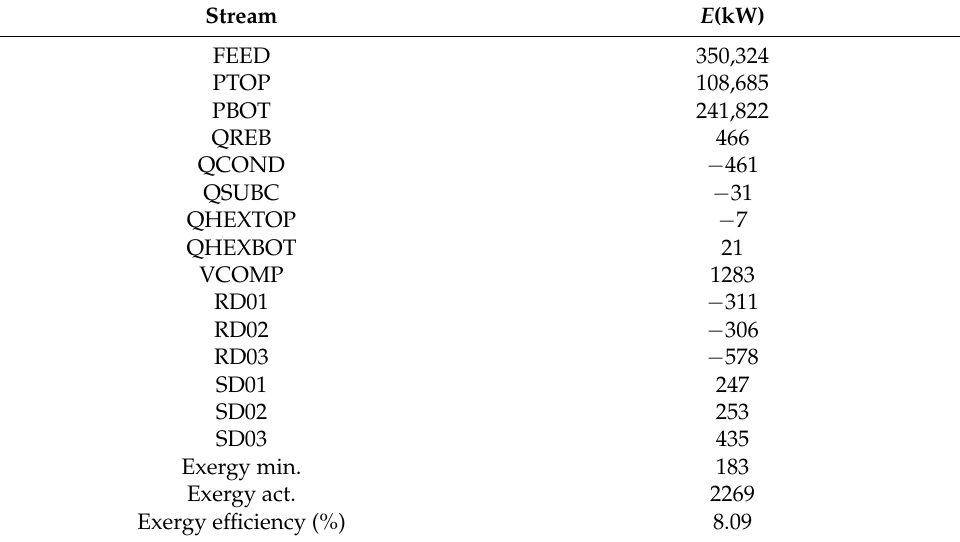
Figure 2. Schematic representation of the iHIDiC model in Aspen Plus ® [49]. Table 4. Exergy analysis of the iHIDiC